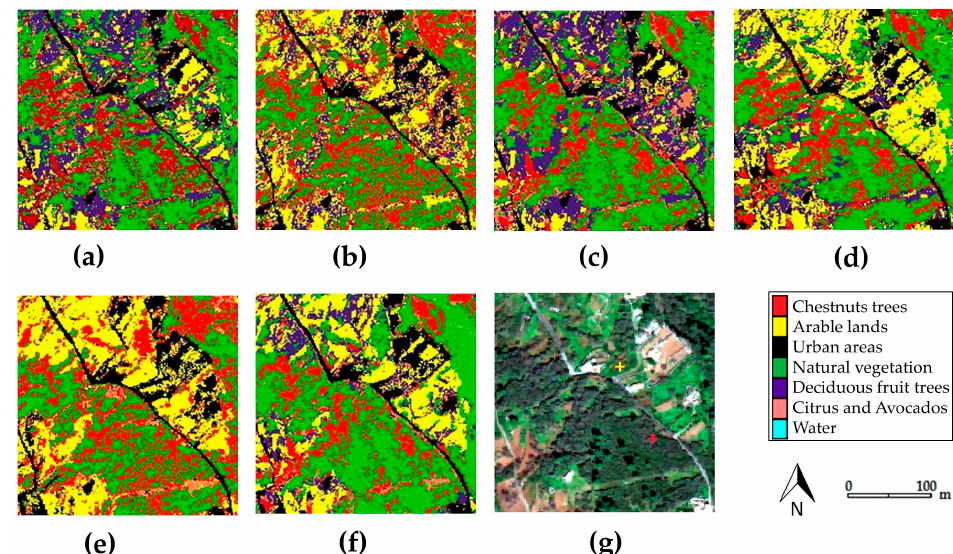
Figure 7. A zoomed-in image (28°22'35.75"N, 16°30'22.21"W; 28°22'25.49"N, 16°30'10.32"W) of the study area classified with RF: ( a ) March, ( b ) May, ( c ) Bi-temporal, ( d ) Mar_EMP, ( e ) May_EMP, ( f ) Bi-temporal_EMP, ( g ) True colour image of 12 March 2015. The two crosses show the validation plots in this portion of the study area: in yellow for arable lands and in red for chestnut trees .